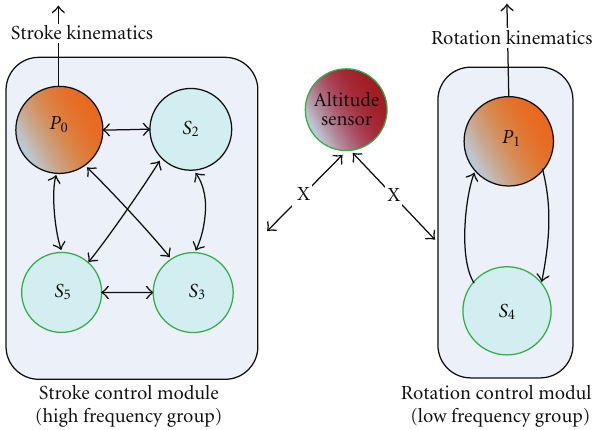
Figure 28: A pictorial representation of the “frequency-based grouping” process combined with intergroup lesion study in absence of the external sensor input for the nonautonomous cruise mode controller shown in Figure